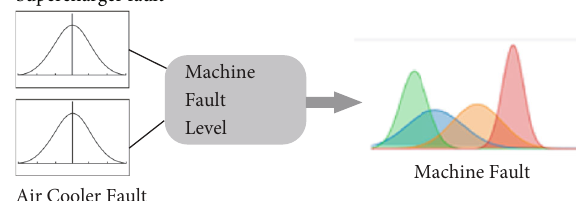
Figure 1: State transition